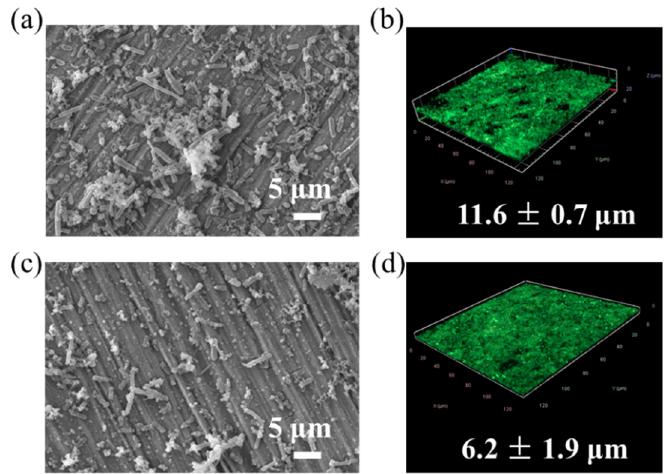
Figure 1. SEM and CLSM images of biofilms grown on Q235 coupons after seven days immersion in different culture media: ( a , b ) T. mesophilum D-6, ( c , d ) Bacillus sp. Y-6. Green color represents live cells with high metabolic activity.